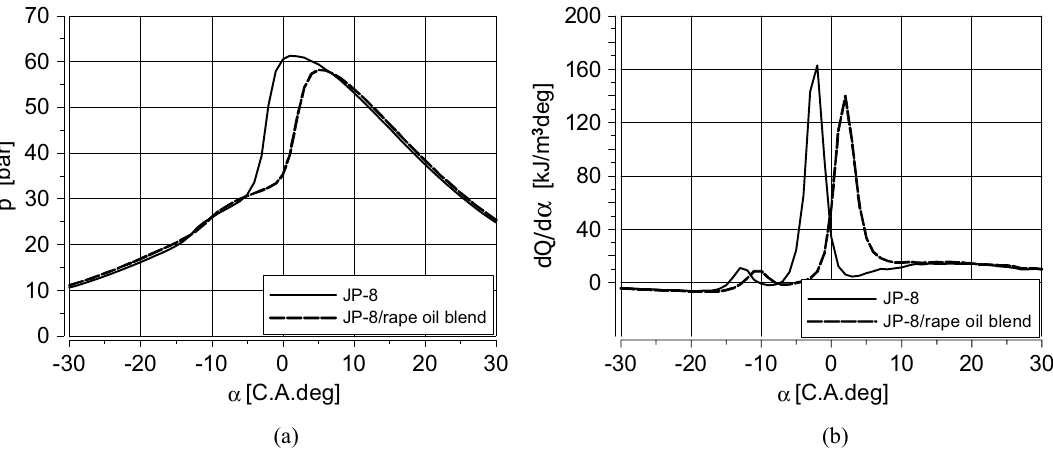
Figure 3. Cylinder pressure diagrams ( a ), and the volumetric heat release rate ( b ) for the same BMEP = 3.45 bar for fueling with JP-8 (η